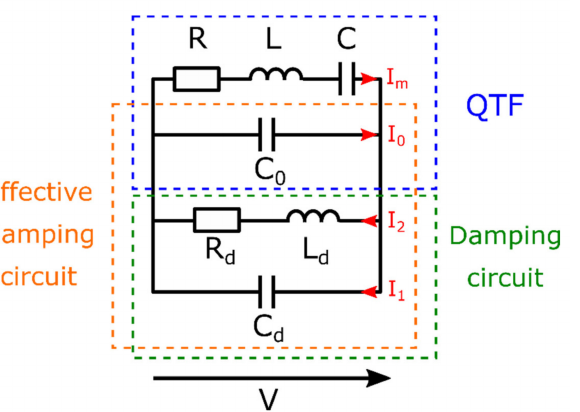
Figure 1. Schematic of the Quartz Tuning Fork (QTF) and the damping circuit. ( R = 100 k Ω , L = 6 kH, C = 4 fF, C 0 = 2